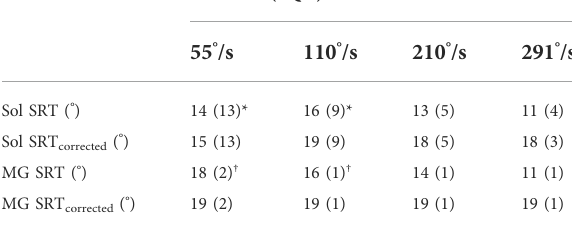
TABLE 2 Effects of stretch velocity on Sol and MG SRT with and without latency correction.